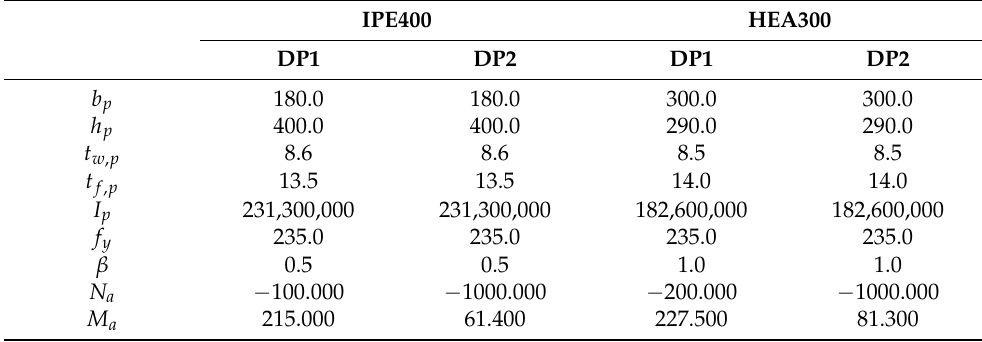
Table 3. Input parameters (all dimensions are in mm except for N a , M a , f y and I p , whose dimensions are kN, kNm, MPa and mm 4 , respectively).